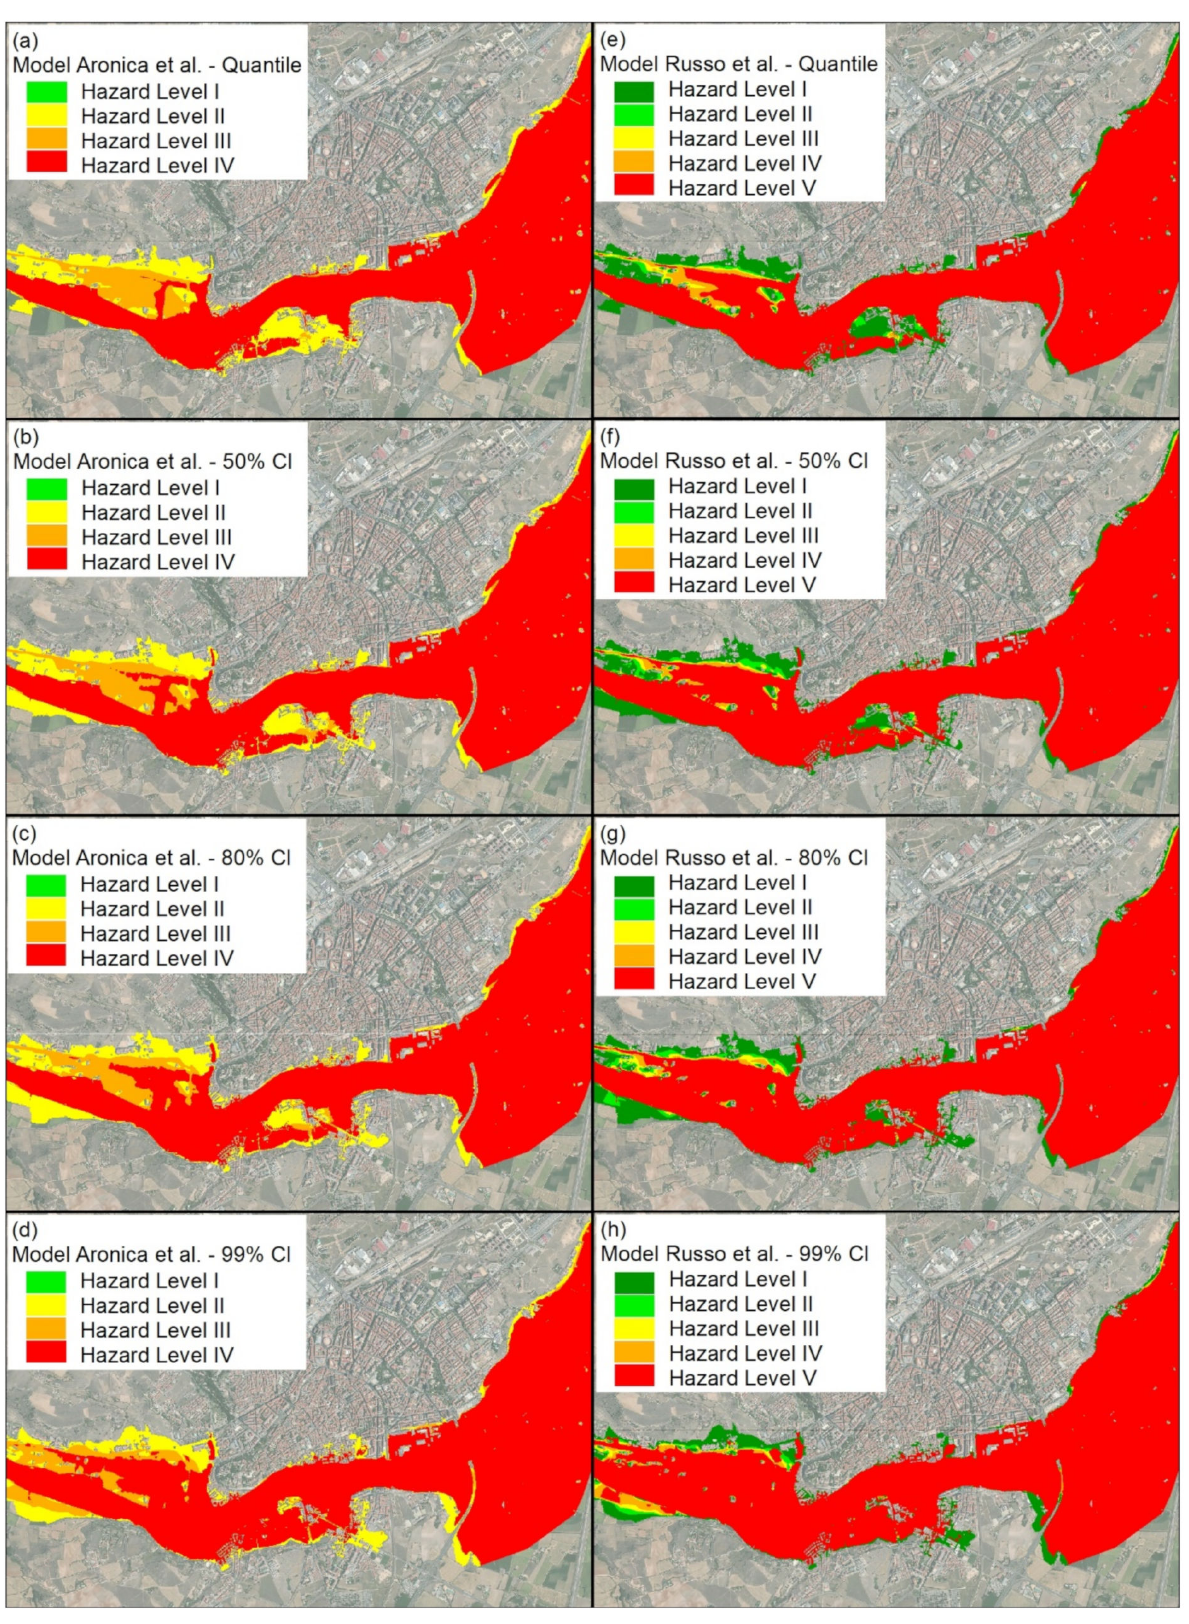
Figure 5. Probabilistic map of human loss of stability areas in Zamora city (Spain) for the Aronica et al. [5] model ( a – d ), and Russo et al. [31] model ( e – h